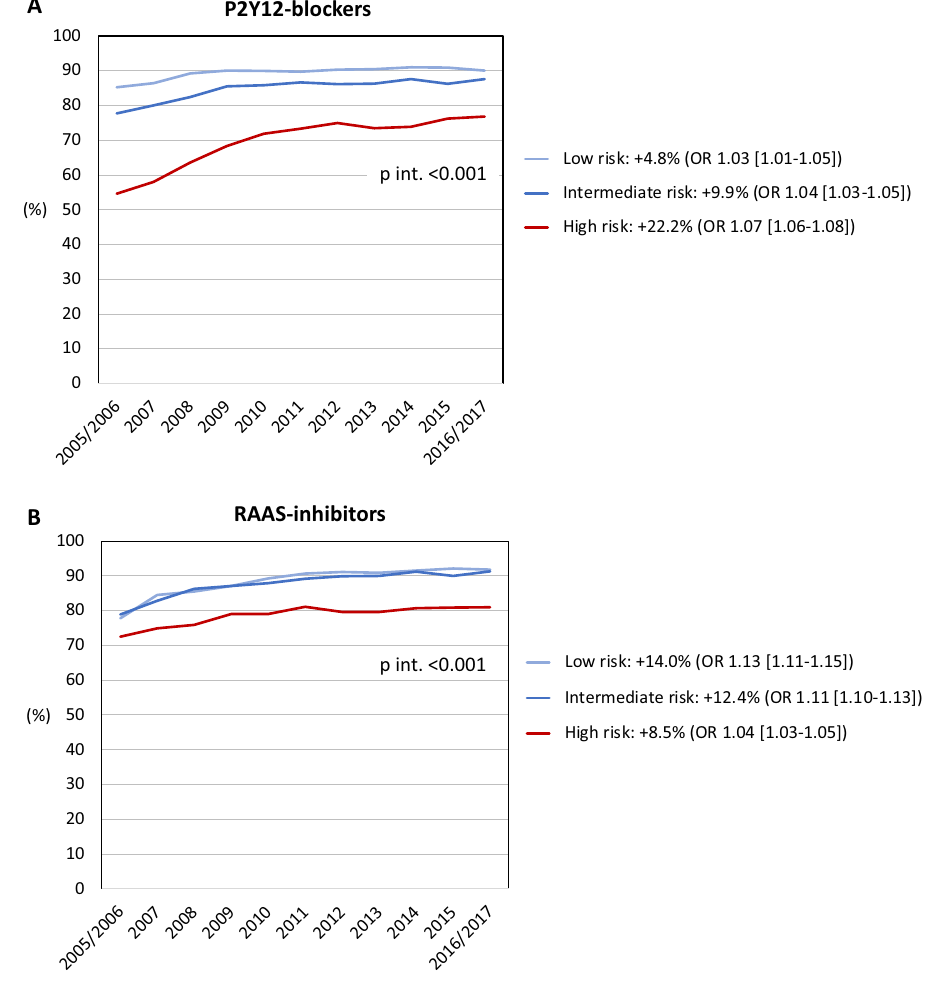
Figure 4. Temporal changes in pharmacological treatments at discharge. ( A ) P2Y12-blockers; ( B ) RAAS- inhibitors. Percentages refer to changes in the rates of pharmacological treatments from 2005/2006 to 2016/2017. p int. refers to the interaction between year of admission and risk group on the utilization of pharmacological treatments. Odds ratios (OR; with 95% confidence intervals) describe the adjusted associations of the year of admission (2005/2006 vs. 2016/2017) with pharmacological treatments. Only in-hospital survivors had been considered. RAAS